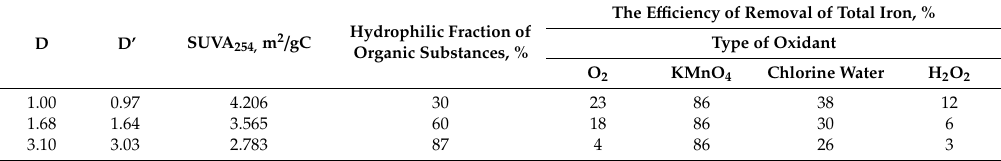
Table 4. The impact of the type of oxidant, values of the D (TOC / Fe tot ) and D’ (DOC / Fe tot ) coe ffi cients as well as the values of SUVA 254 and hydrophilic organic content (%) coe ffi cient on the e ffi ciency of removal of total iron from groundwater in oxidation and sedimentation processes. The E ffi ciency of Removal of Total Iron, % Hydrophilic Fraction of Type of Oxidant D D’ SUVA 254, m 2 / gC Organic Substances, % O 2 KMnO 4 Chlorine Water H 2 O 2